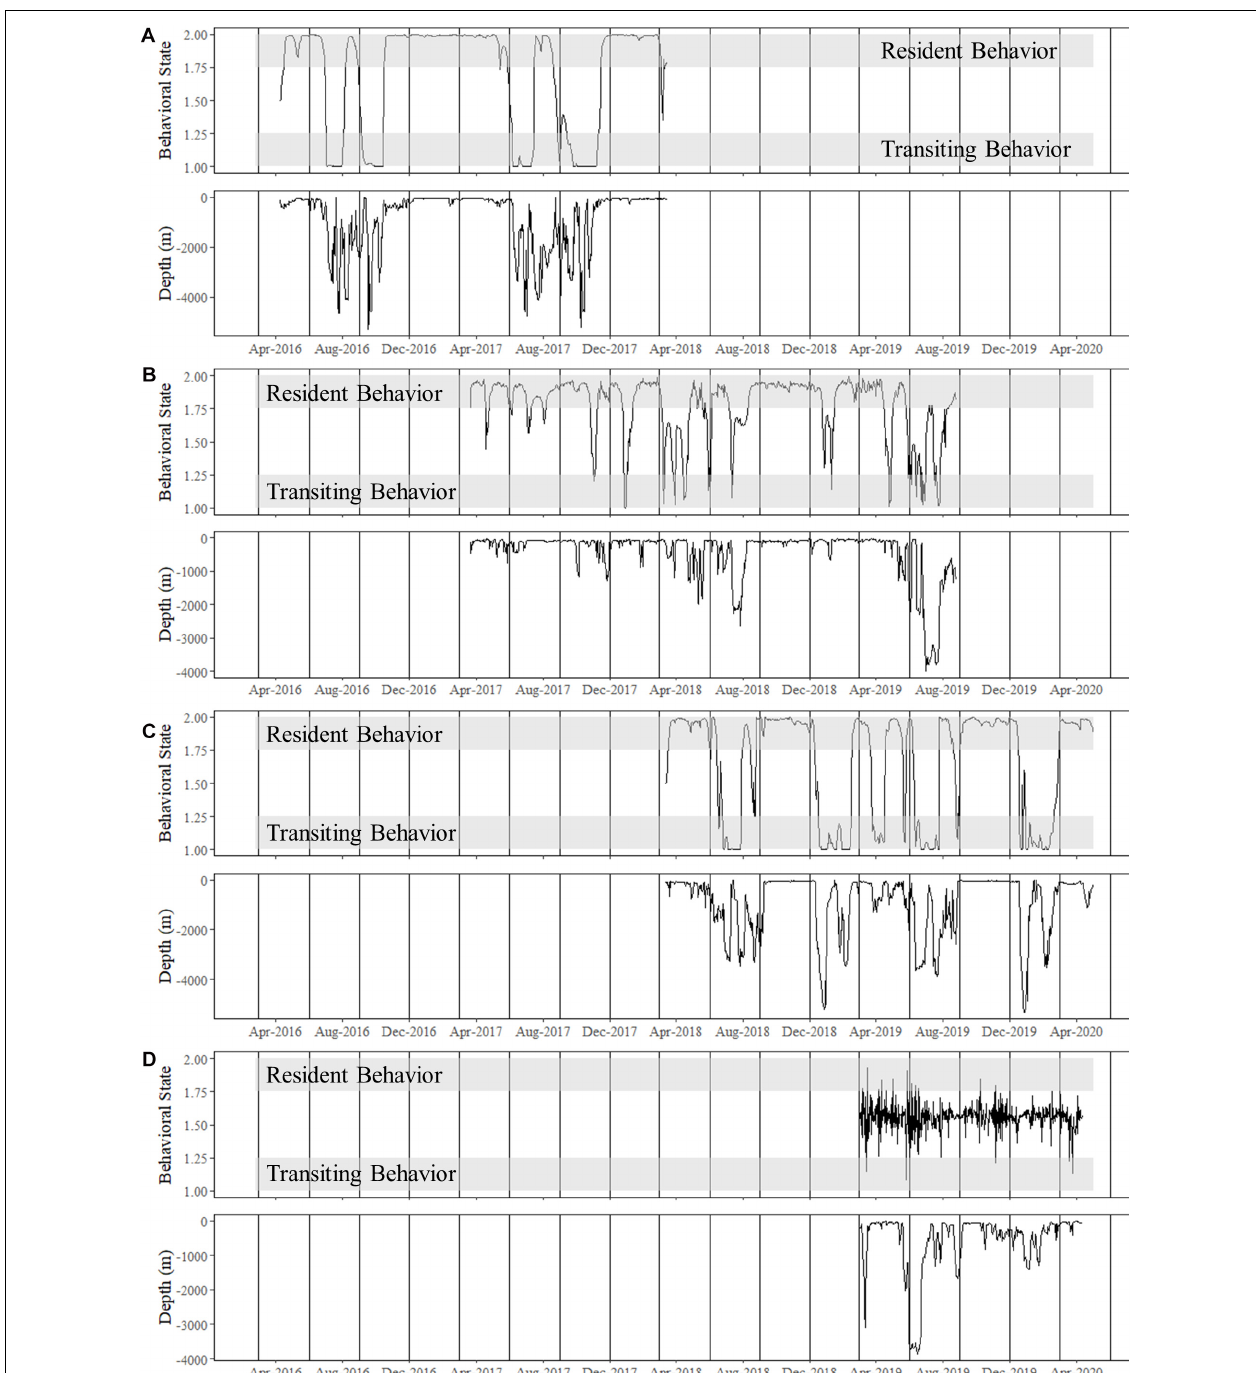
FIGURE 5 | Time series of estimated behavioral state for shortfin makos tracked for multiple years compared to ambient depth use (m), or depth of ocean floor over which the shark was positioned. Note that deeper ambient depths were observed when sharks were transiting. Vertical lines represent the start of each